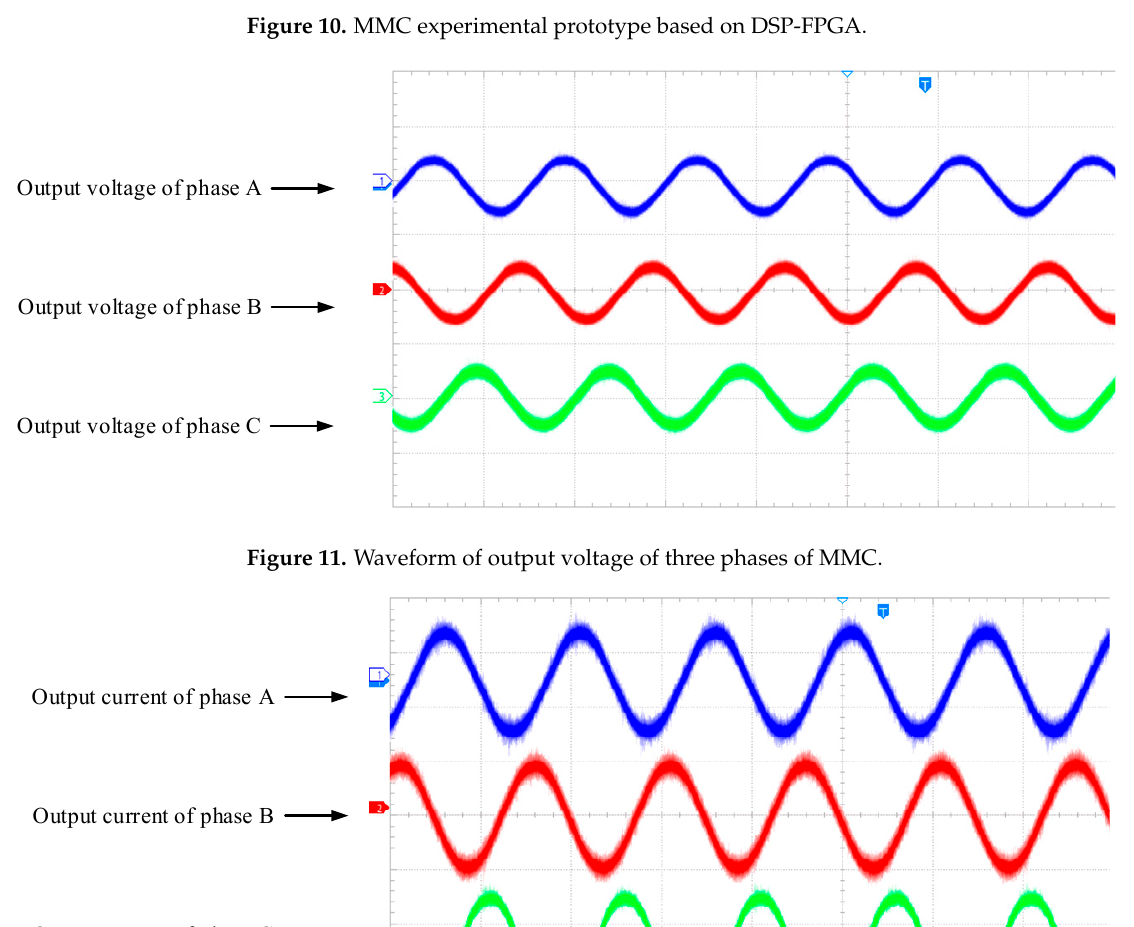
Figure 10. MMC experimental prototype based on DSP-FPGA.